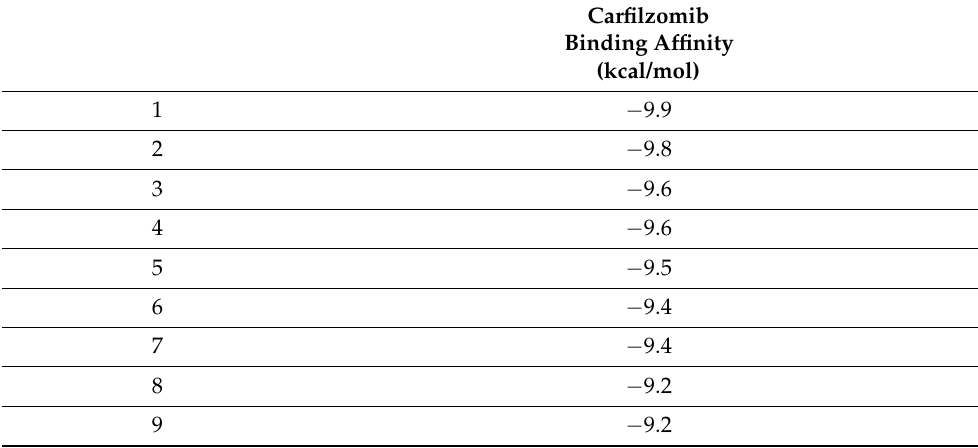
Table 2. Predicted binding affinity values of CFZ to IDE for the best nine poses obtained by docking